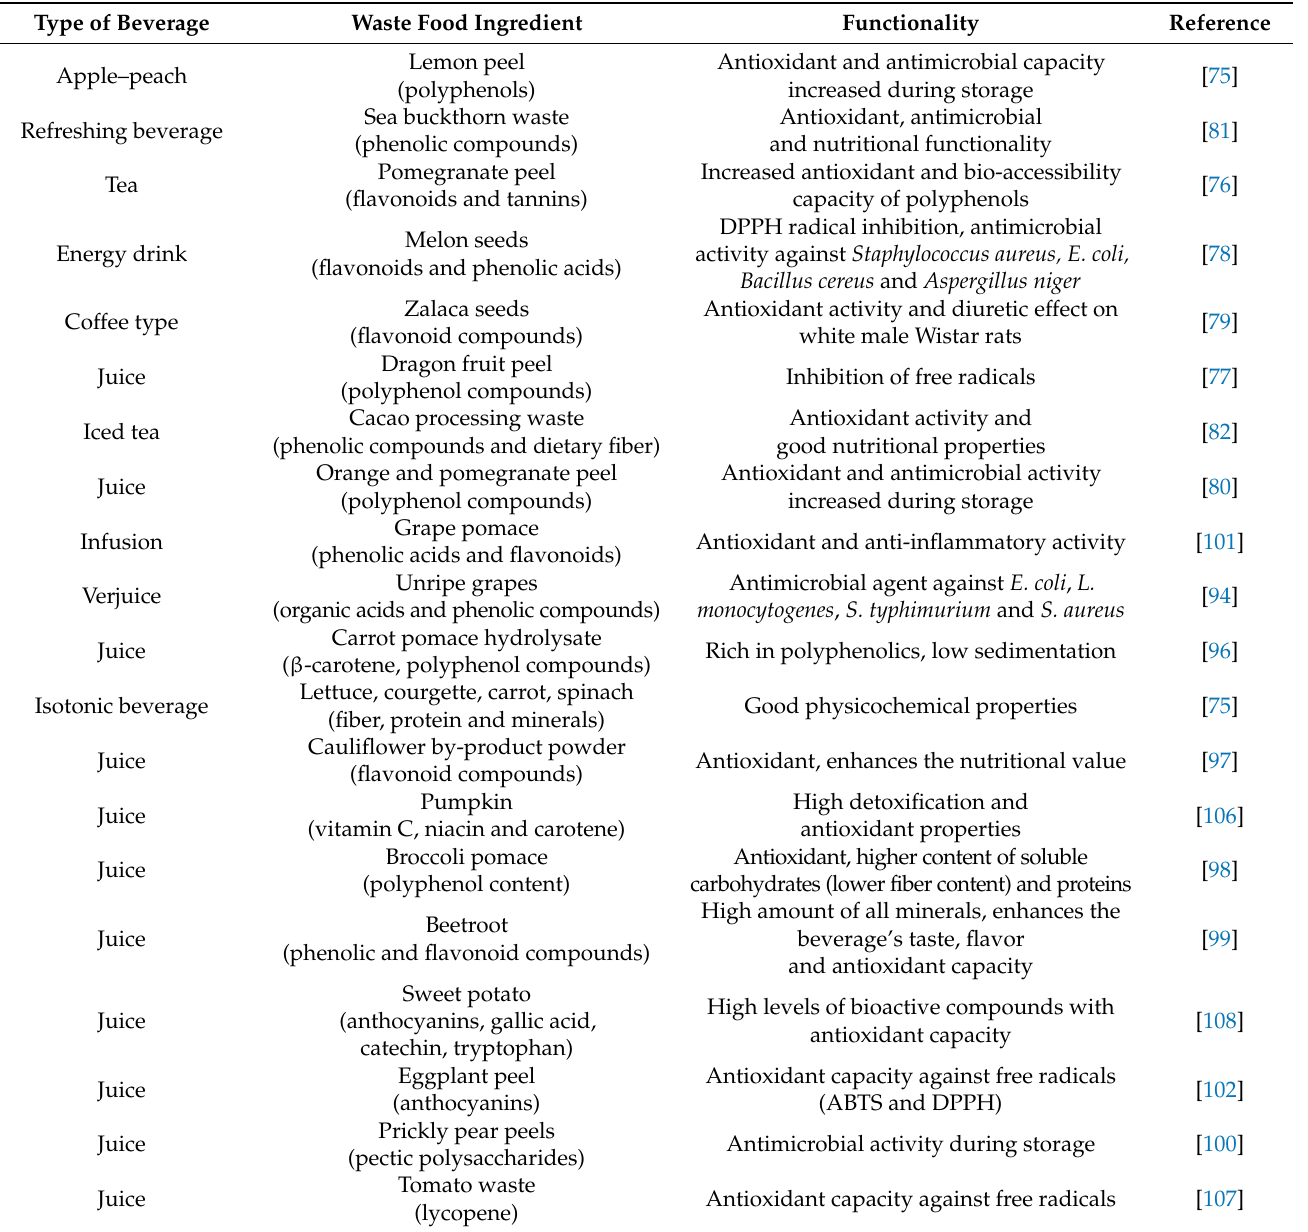
Table 2. Fruit and vegetable waste used in functional